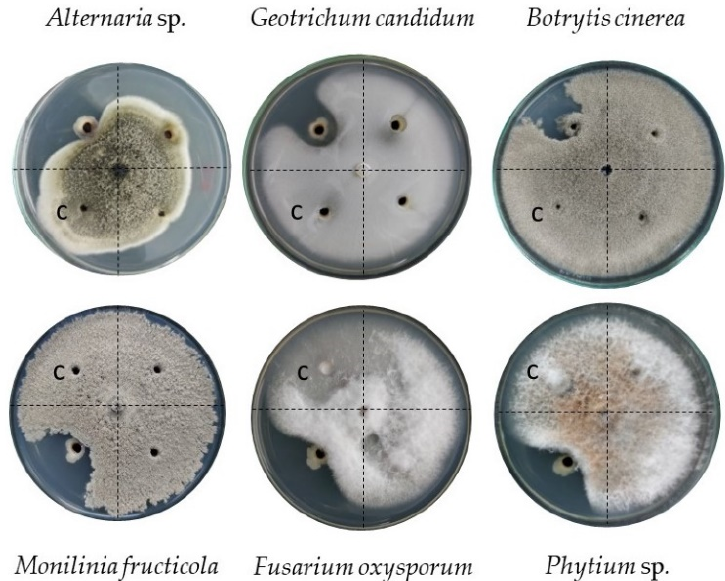
Figure 5. In vitro determination of biocontrol of Pseudomonas sp. strain C3 against six phytopathogenic fungi. The letter “C” in the Petri dish indicates the quadrant that corresponds to the control without bacteria.